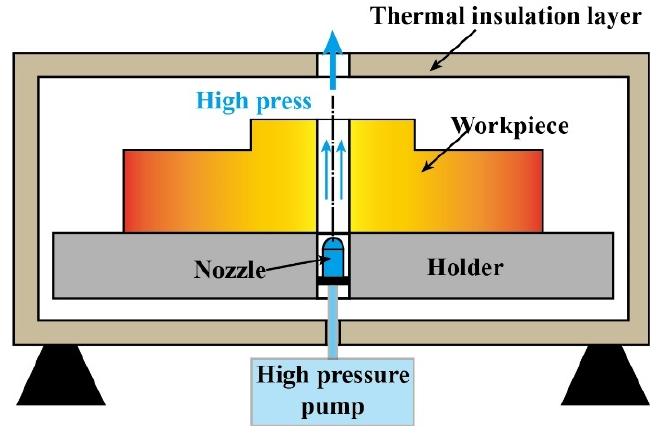
Figure 4. GH4169 alloy heat treatment process.